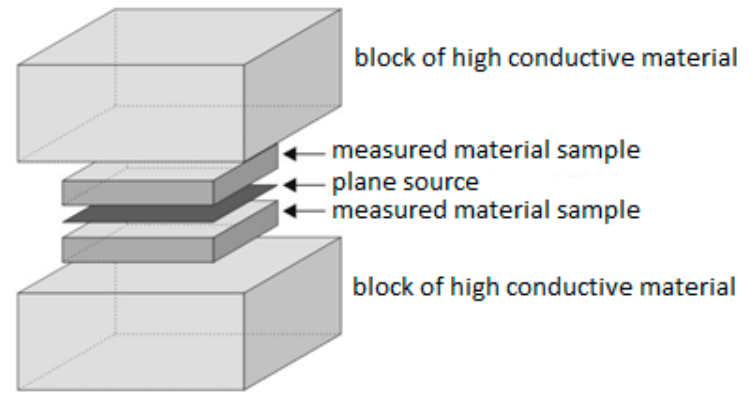
Figure 1. The EDPS apparatus scheme. The plane source (Figure 1) is measuring changes of electrical resistance R and com- puted temperature from the linear relation between electrical resistance and temperature, which for the plane source is characterized by the resistance temperature coefficient 4.8 ×